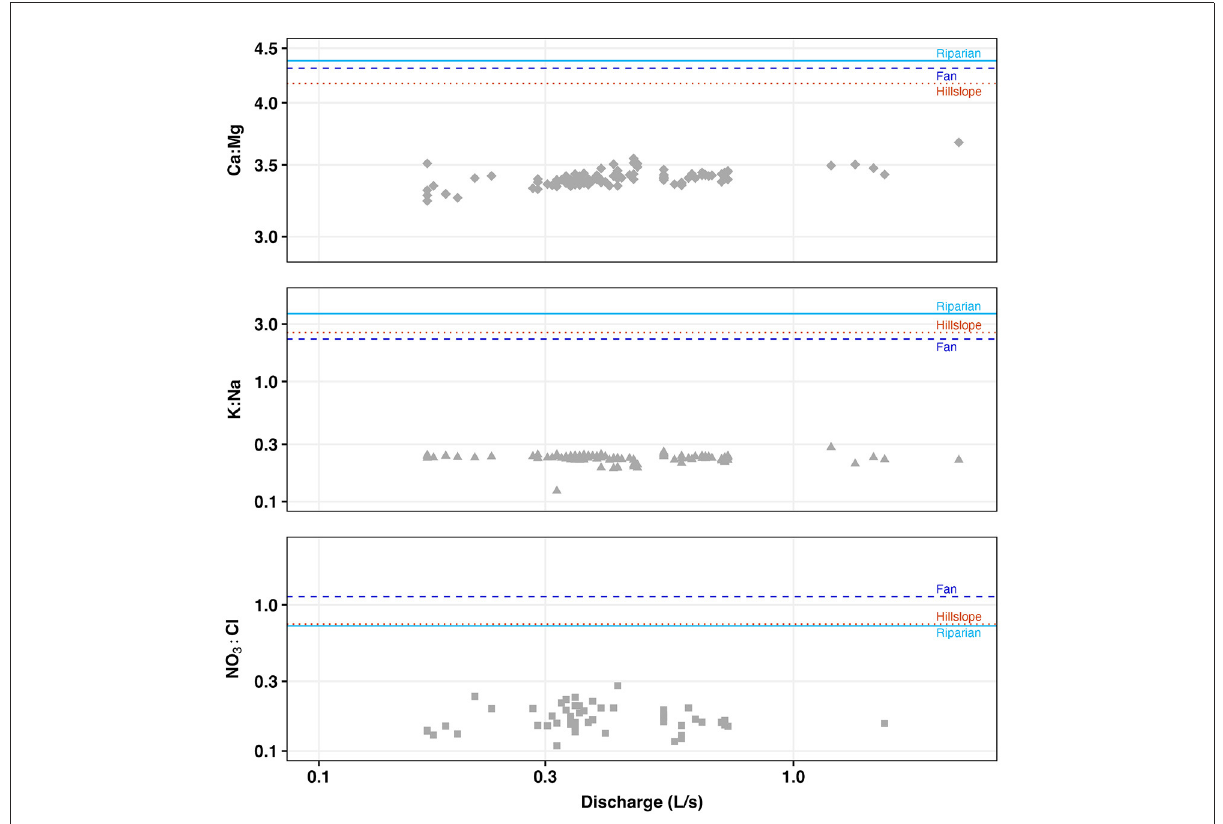
FIGURE6 Molar ratio-discharge relationships of 2020 stream samples (gray) for Ca:Mg. K:Na, and NO 3 in comparison to mean soil molar ratio values of the sampled landscape units (light blue, riparian; dark blue, alluvial/colluvial fans; orange,